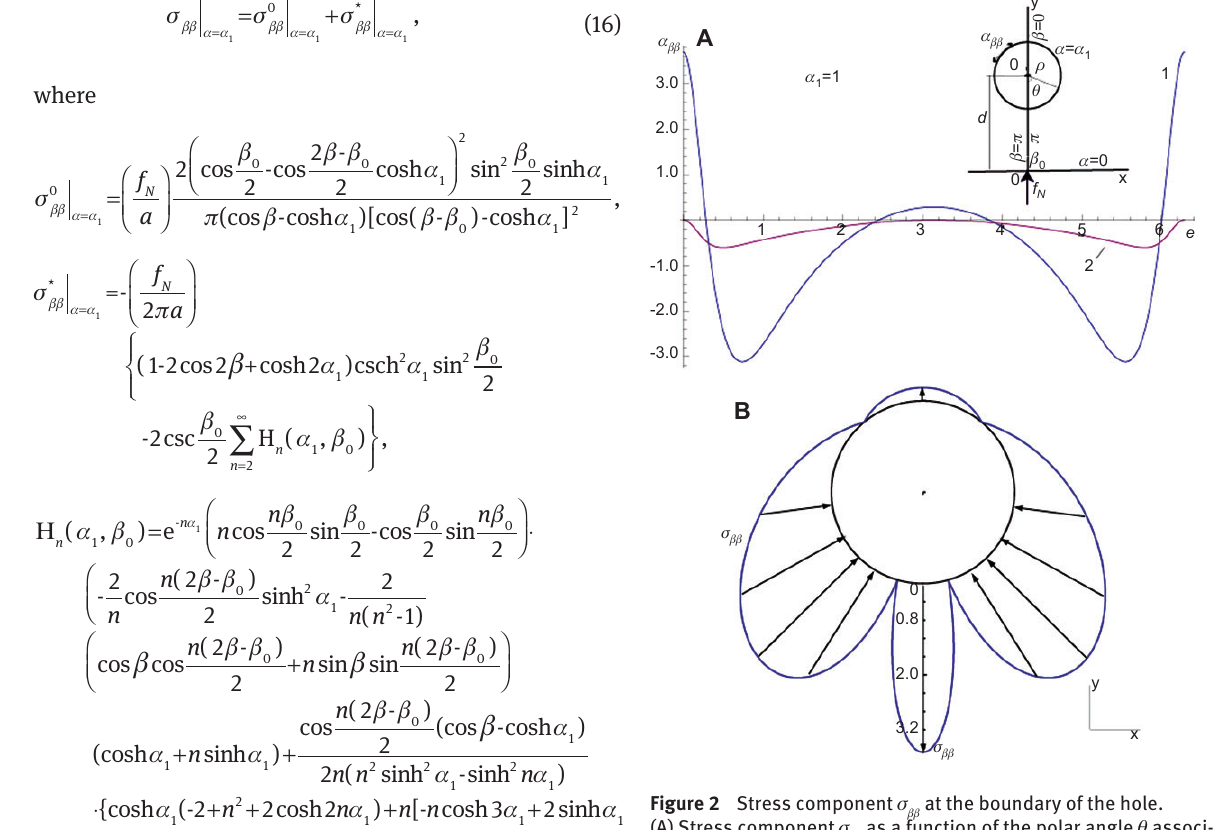
Figure 2 Stress component σ at the boundary of the hole. β β (A) Stress component σ as a function of the polar angle θ associ- β β )]} . ated with the hole. Stresses are given for the boundary of the hole = 1 (1), which corresponds to the aspect ratio with coordinate α 1 d = = δ 1.54 . For comparison, the same component is shown for a ρ = 1 (2). (B) Stress diagram at the uniform half-space on the line α = α 1 boundary of the hole. Concentrated force is applied normally to the = ± π . The stresses are straight boundary of the half-space at point β 0 f shown in units of . N a